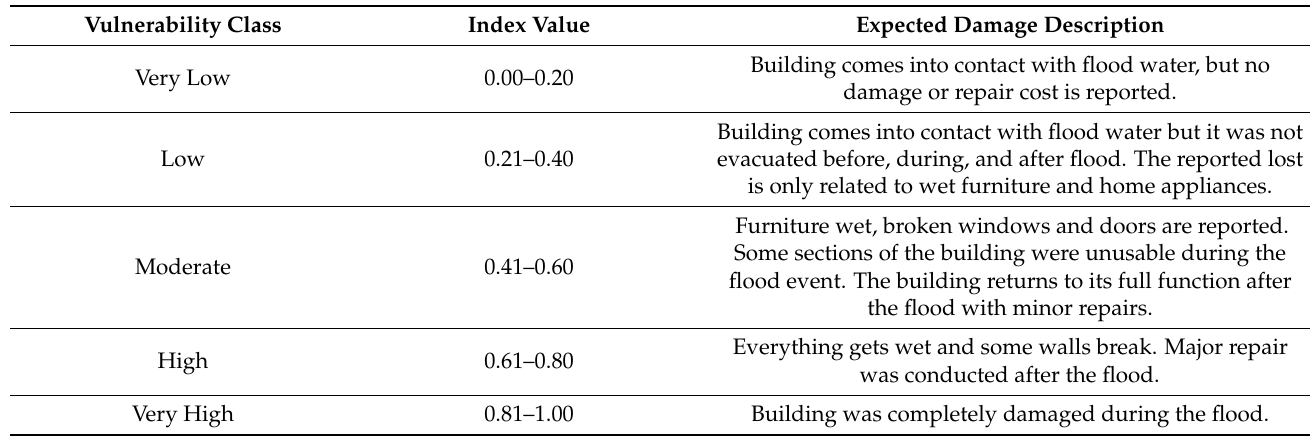
Table 5. Categorization of damage description.